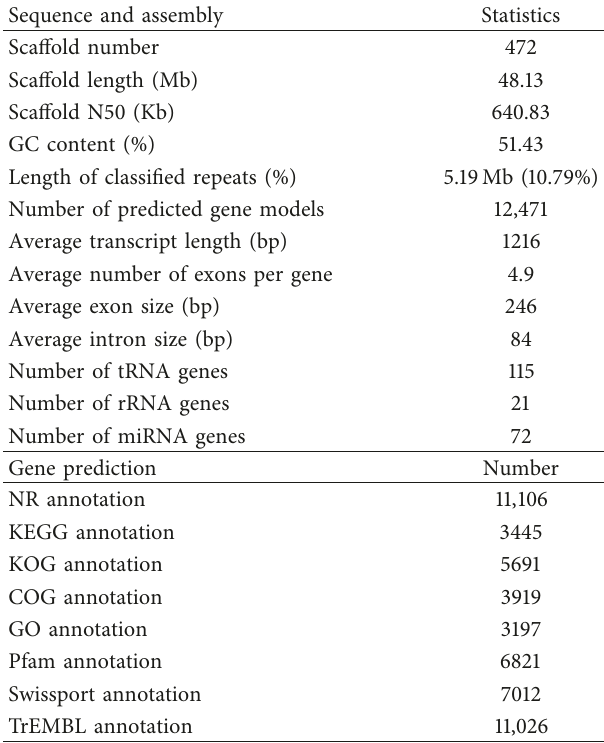
Table 1: Summary statistics of the S. latifolia